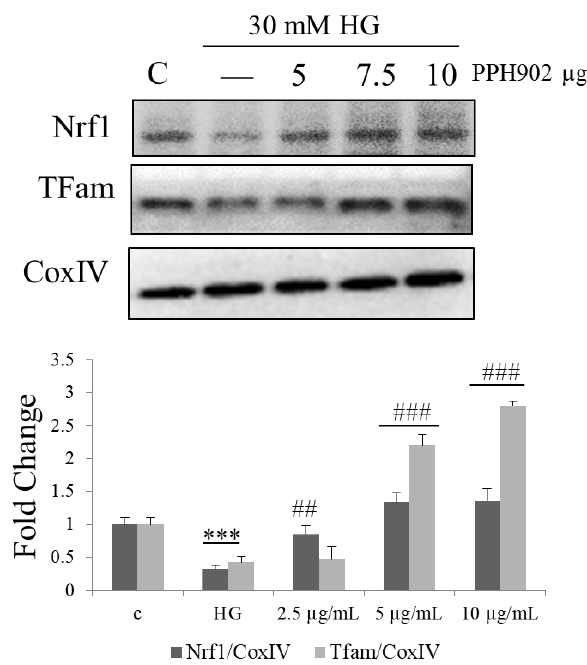
Figure 9. Effect of PPH902 on the activation of mitochondrial biogenesis: Representative Western blotting shows changes in the levels of NRF1 and TFAM in C2C12 cells. *** p < 0.001 indicates a significant difference with respect to control groups and ## p < 0.01 and ### p < 0.001 indicates a significance difference with respect to the high glucose challenge